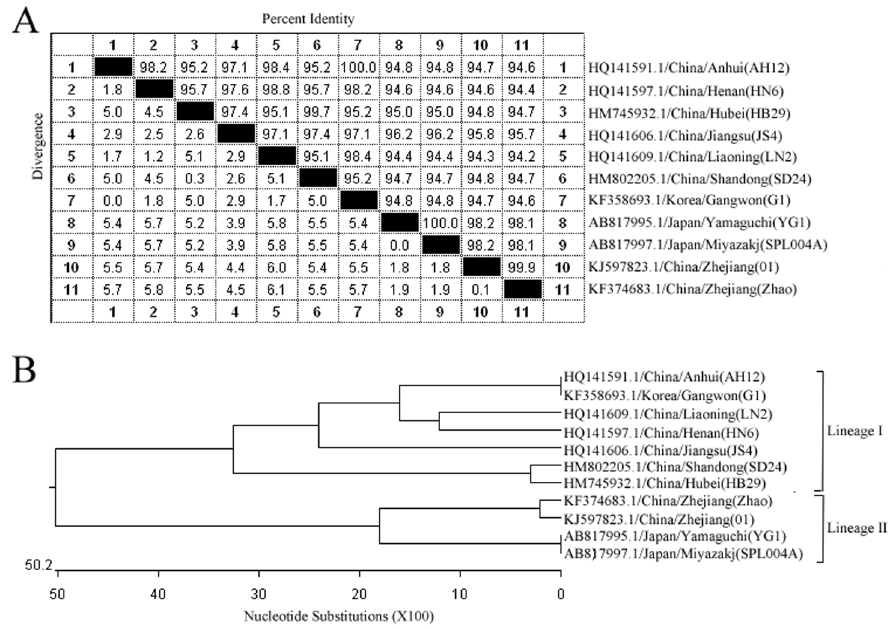
Figure 3. Homology comparison of the target nucleocapsid gene sequences from different SFTSV strains. A: The similarities of the target nucleocapsid gene sequences from the SFTSV strains of China (Henan, Liaoning, Shandong, Jiangsu, Hubei, Zhejiang and Anhui), Japan (Yamaguchi and Miyazakj), and South Korea (Gangwon) were 94.2–100%. B: Phylogenetic tree showed the phylogenetic positions of SFTSV strains in Zhejiang (Daishan), compared with other known SFTSV strains.